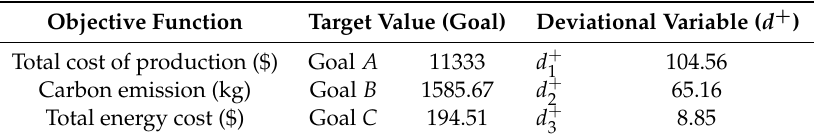
Table 9. Optimal results of the mathematical model.